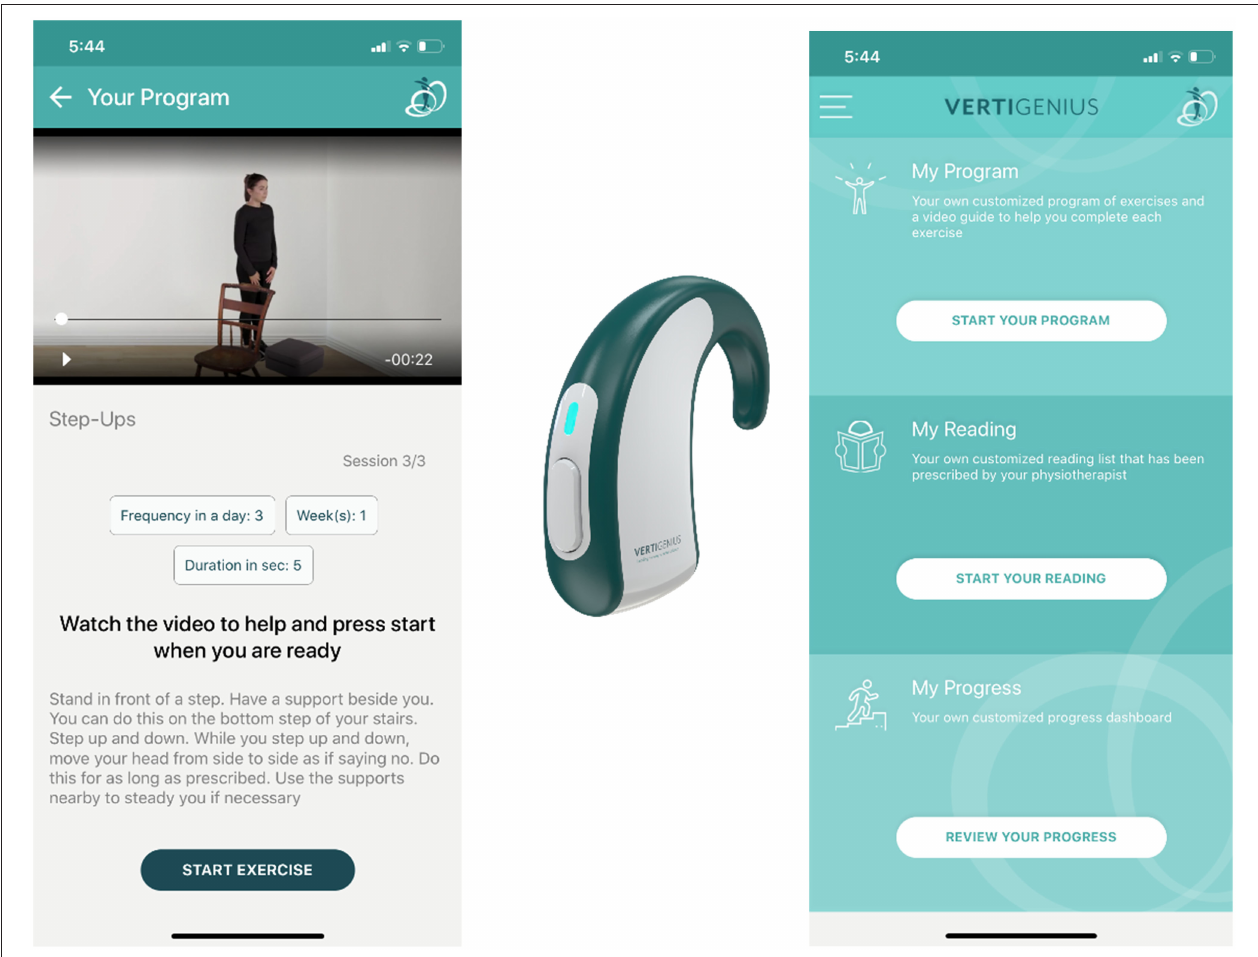
FIGURE 1 | Patient-facing application and wearable head